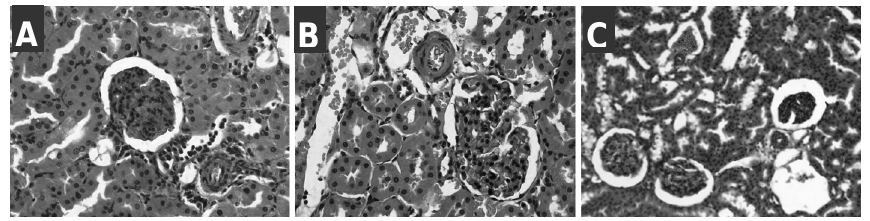
Figure 1. H&E staining was performed in glomerulus and renal tubule from control, streptozotocin- diabetes and insulin-treated rats. A: control group ;B: diabetic group C: diabetic and insulin-treated